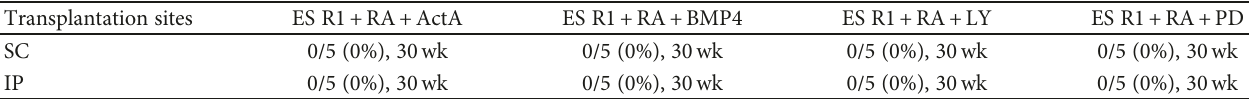
Table 2: Tumor development in nude mice after transplantations of ES R1 stimulated with RA in combination with Activin A, BMP4, PD98059, and